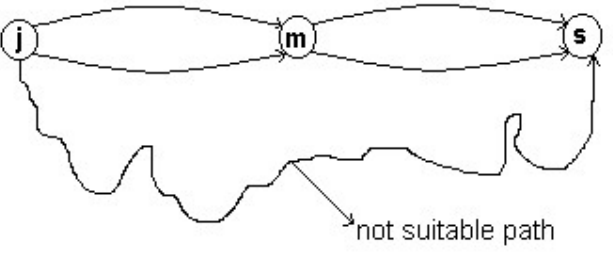
Fig.1. Suitable / not suitable paths, and k-link connected N/D